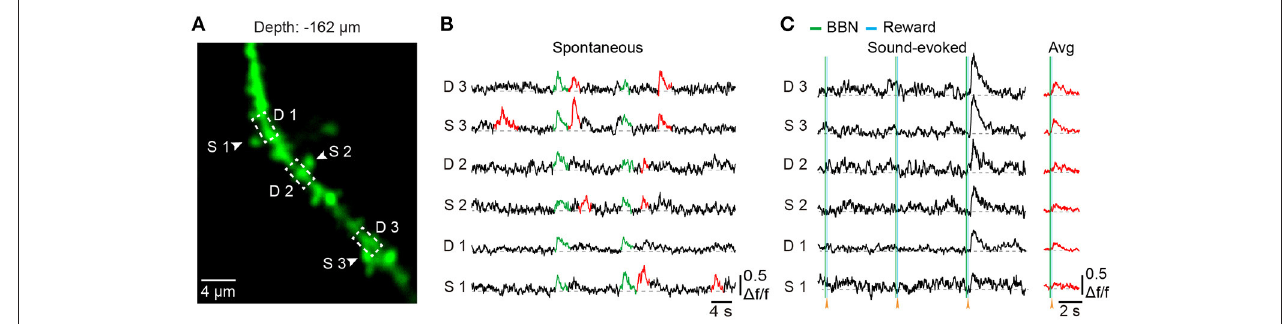
FIGURE 6 | Spine Ca 2 + imaging using electroporation in the Au1 of behaving mice . (A) Average image (1,800 frames) of a dendritic segment. (B) Spontaneous Ca 2 + transients of 3 spines (marked with arrowheads in A and their corresponding dendritic shafts (outlined with a dashed rectangle in A . Green indicates the assembly of dendritic inputs, and red indicates the single-spine inputs. (C) Three consecutive trials of sound-evoked Ca 2 + transients from the same spines and dendritic shafts as in B